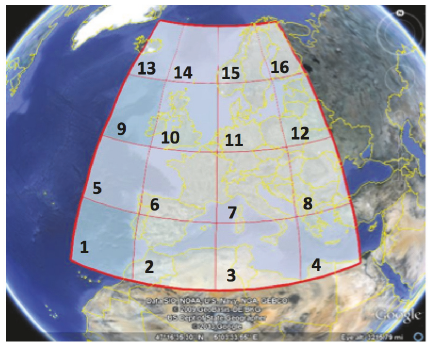
Figure 5: Geographic layout of the 16 sectors of the case